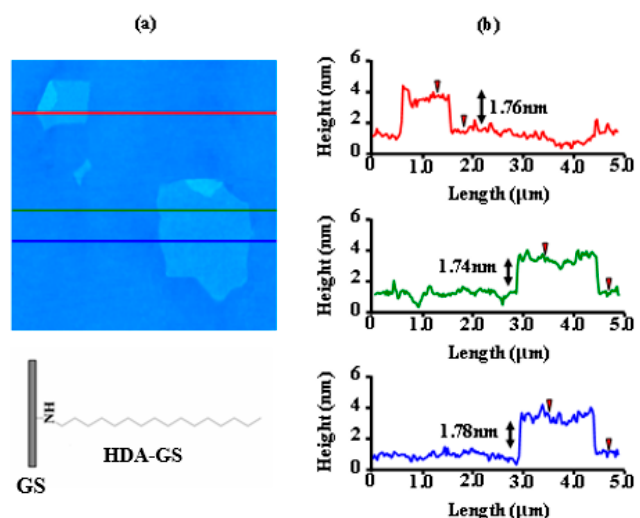
Figure 3. ( a ) Noncontact-mode AFM image of HDA-GS sheets with ( b ) three height profiles acquired in different locations.